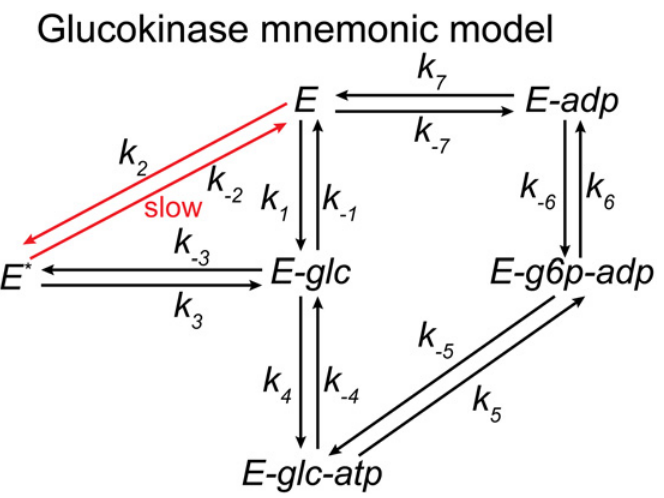
Fig 4. Schematic representation of the mnemonic model for the mammalian glucokinase. This model proposes a slow conformational transition from a low-affinity state ( E * ) to a high-affinity state ( E ) that can be enhanced with increasing glucose concentration yielding the observed cooperative